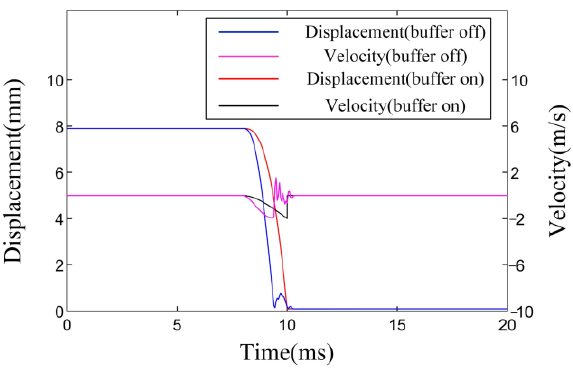
Figure 16. Co-simulation results of EMVV system.